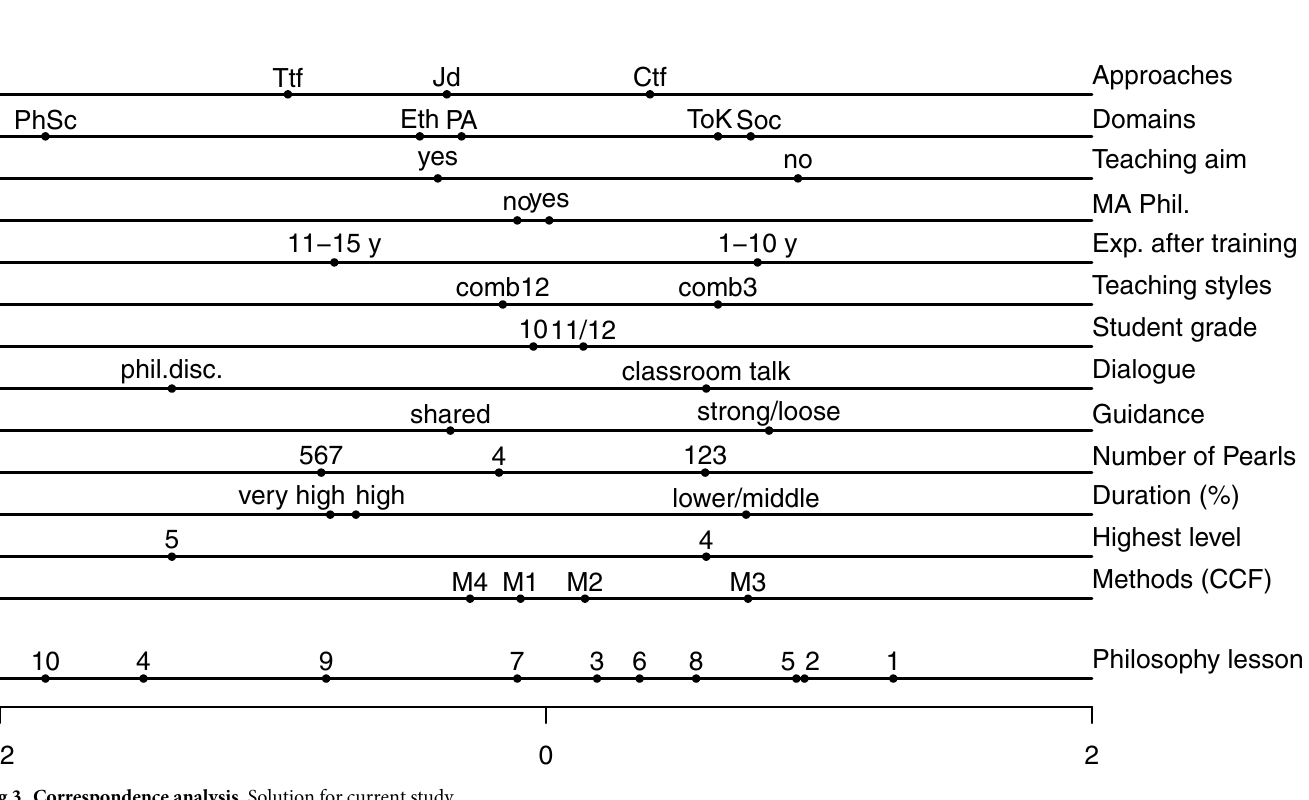
Fig 3. Correspondence analysis. Solution for current